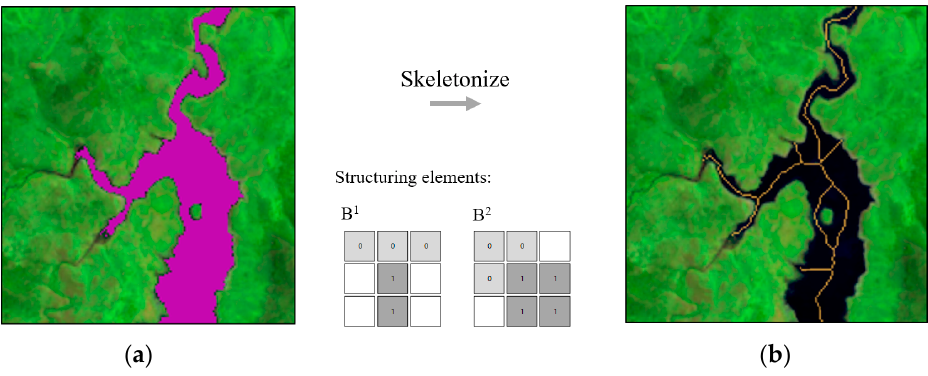
Figure 13. Input water mask ( a ) and results ( b ) of medial axis detection algorithm using mathematical morphology. Structuring elements (kernels) shown in the middle. Four rotated version of the kernels were applied sequentially.